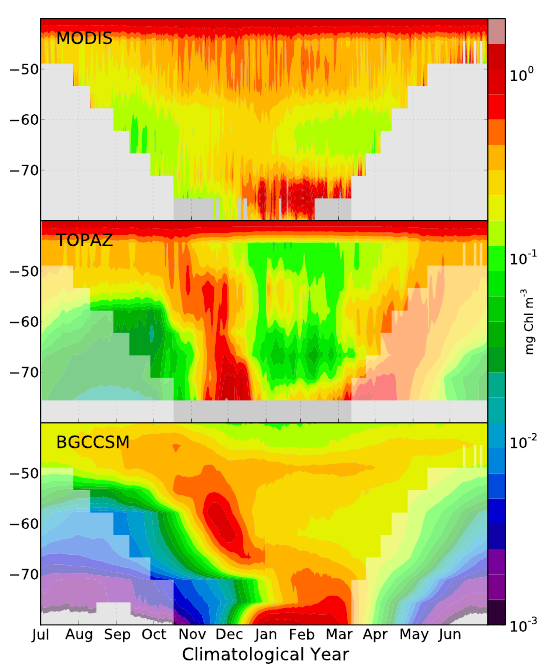
Figure 2. Hofmøller plots of satellite Chl (top panel), Chl simulated by TOPAZ (middle panel), and Chl simulated by BGCCSM (bottom panel) in Drake Passage. All panels are zonal medians within the box. All data that fall on a specific grid cell on a specific day of the year are averaged to one value.